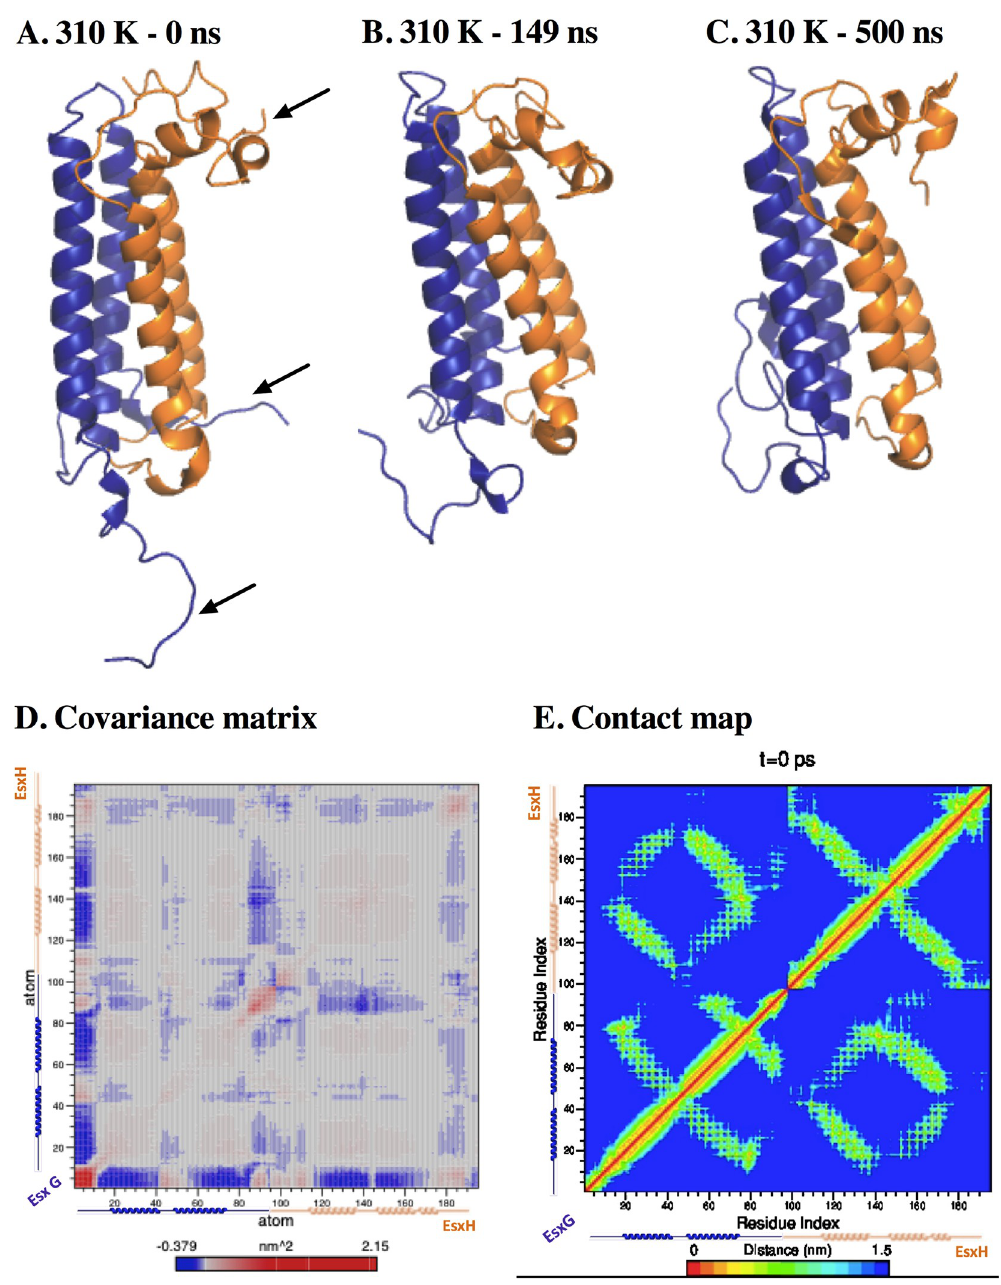
Fig 3. Global structure behavior from EsxG EsxH dimer at 310 K. (A). 0 ns of simulation. Arrows indicate regions that underwent folding. (B). 149 ns of simulation. (C). 500 ns of simulation. Blue depicts EsxG monomer; orange depicts EsxH monomer. (D). First principal component covariance matrix. The matrix is color-coded, from red (correlated displacements) to blue (non-correlated displacements). The diagonal line stands for the correlation between the residues paired with themselves; the blue stands for the correlation between each residue pair during the 500 ns simulation. (E). Contact map. The matrix is color-coded, blue (farthest) to red (closest). The diagonal line represents the zero distance between the residues paired with themselves, while spots represent the distances (nm) for each residue pair during the 500 ns simulation.